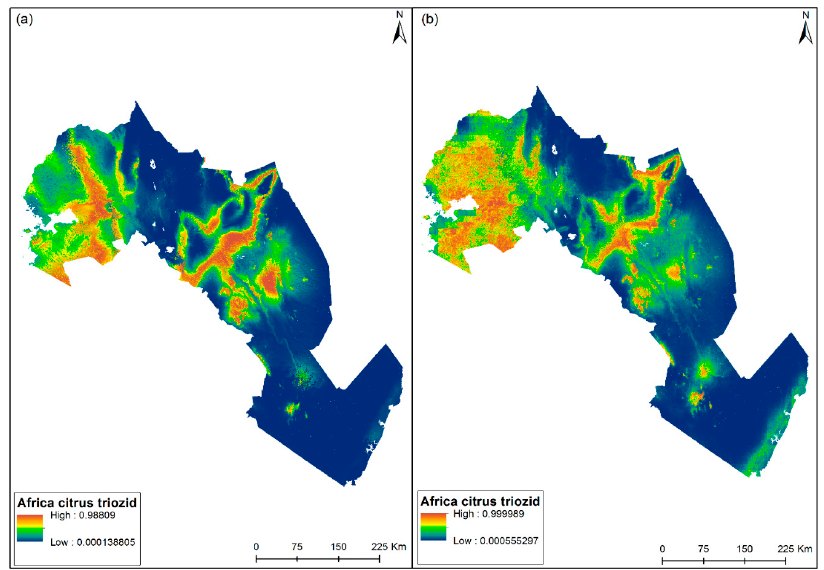
Figure 6. Predicted distribution suitability map for African citrus triozid ( Trioza erytreae ) using environmental (BCL model) variables ( a ), and environmental and remotely-sensed (BCL-RS model) variables ( b ). Blue indicates low distribution suitability, while red represents high distribution suitability.